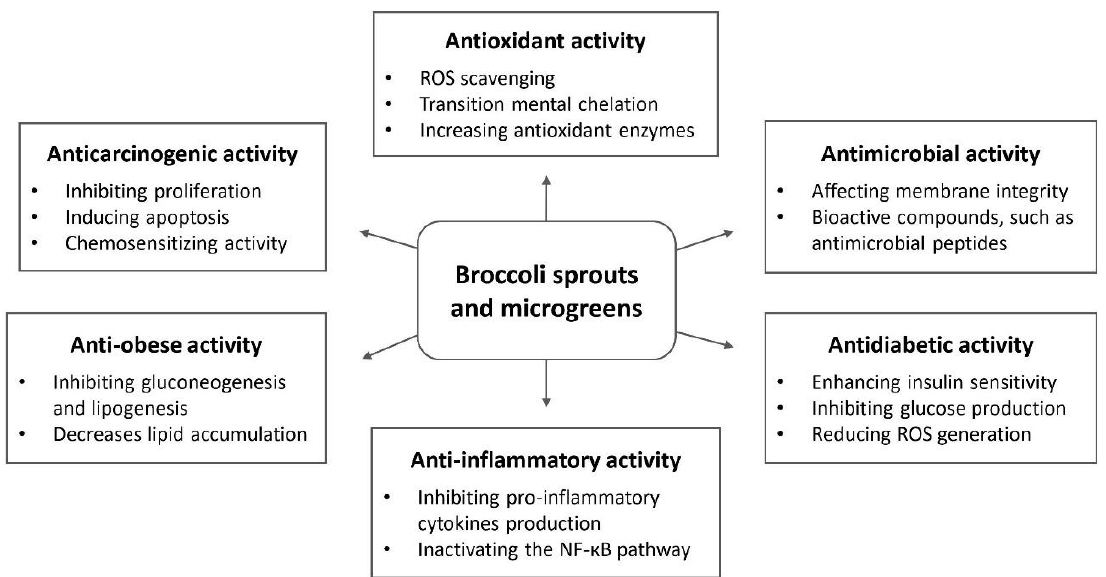
Figure 3. Summary of the biological activities of broccoli sprouts and microgreens with possible mechanisms of action.